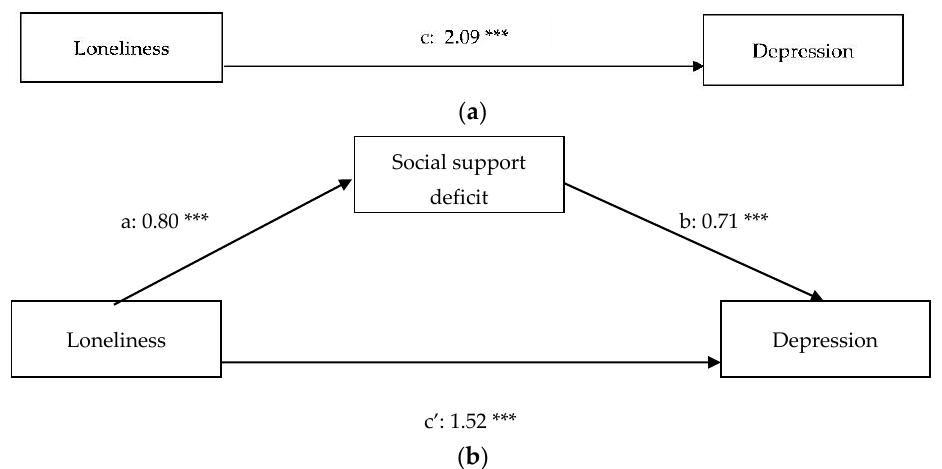
Figure 2. ( a ) Total relationship between loneliness and depression. ( b ) Mediation of the relationship between loneliness and depression. *** p < 0.01.